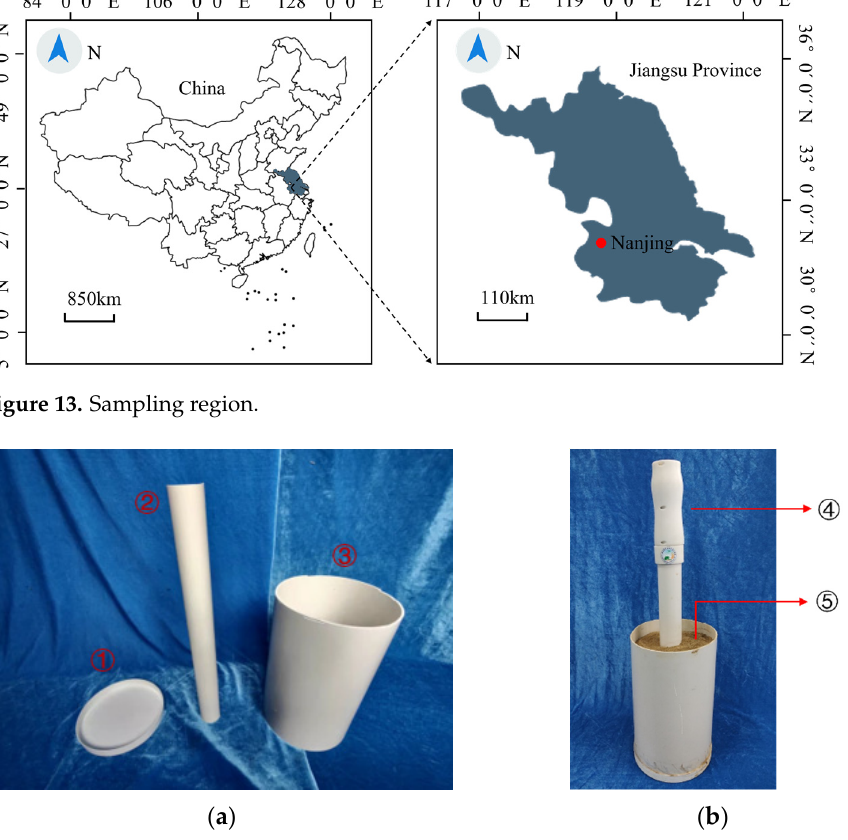
Figure 14. Sensor modification test bucket. ( a ) Modification test barrel parts drawing; ( b ) sensor test chart. ① Lower bo tt om cover; ② inner tube; ③ outer wall; ④ sensors; ⑤ soil sample to be tested.